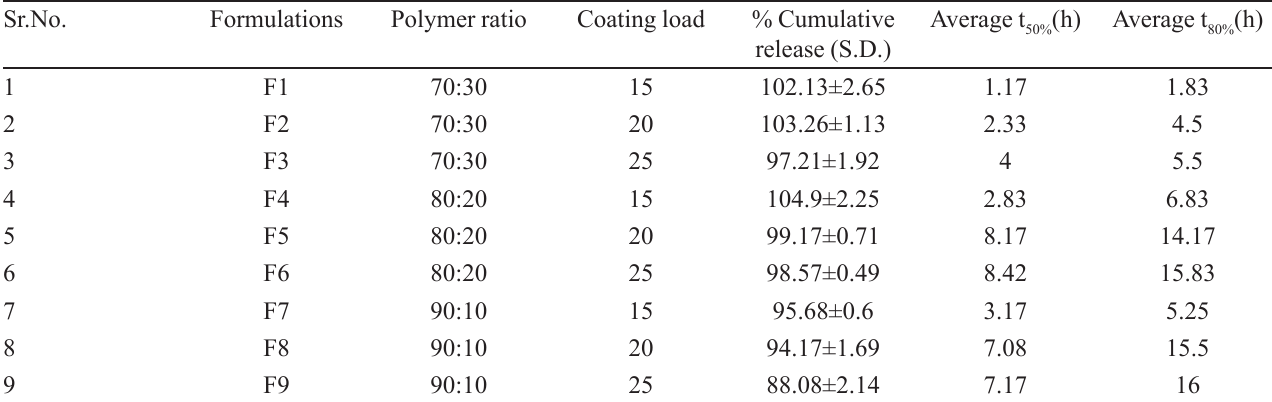
and t of metoprolol succinate pellets 50% 80%